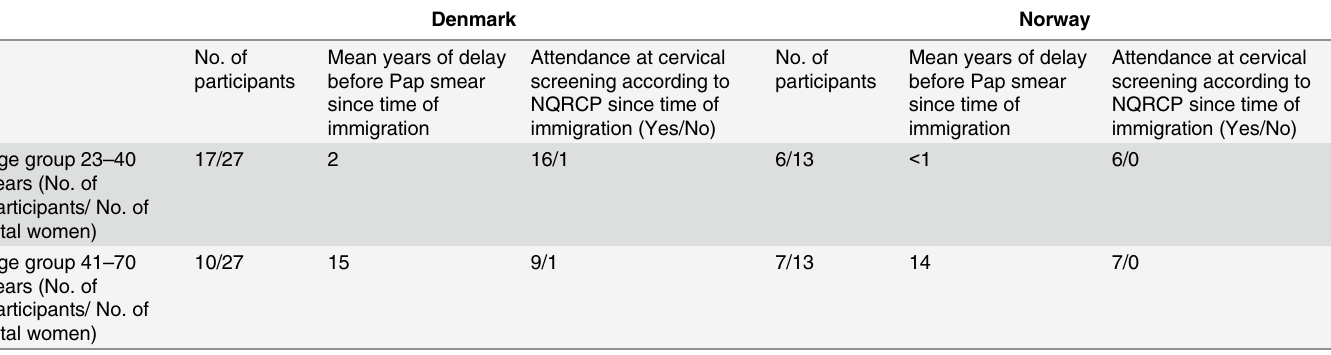
Table 2. Description of attendance at cervical screening of FGD-participants based on information from National Quality Register of Cervical Can- cer Prevention (NQRCP) a